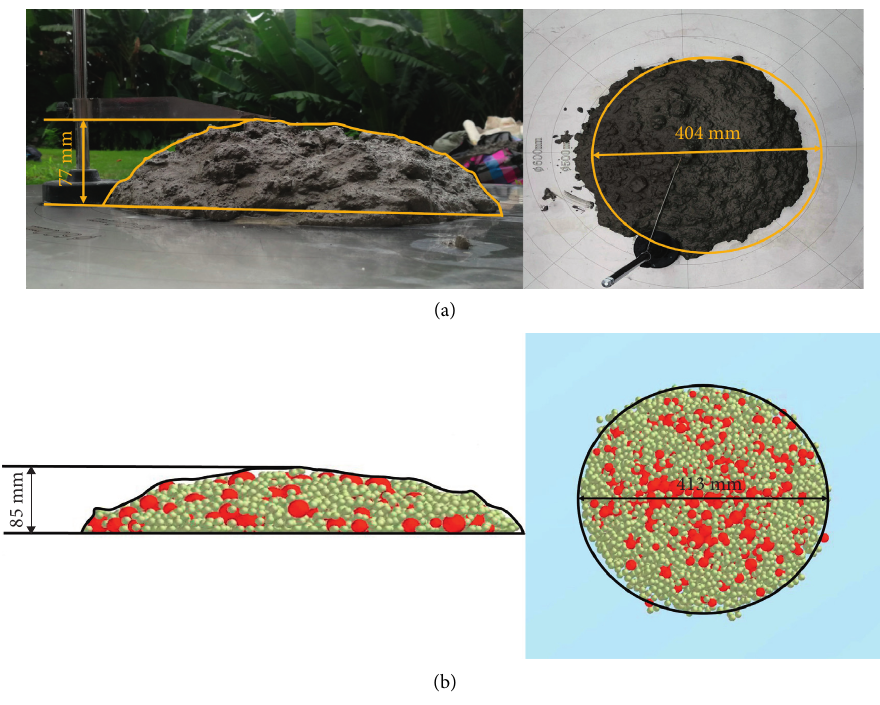
Figure 5: The results of slump tests in experiments (a) and simulations (b).